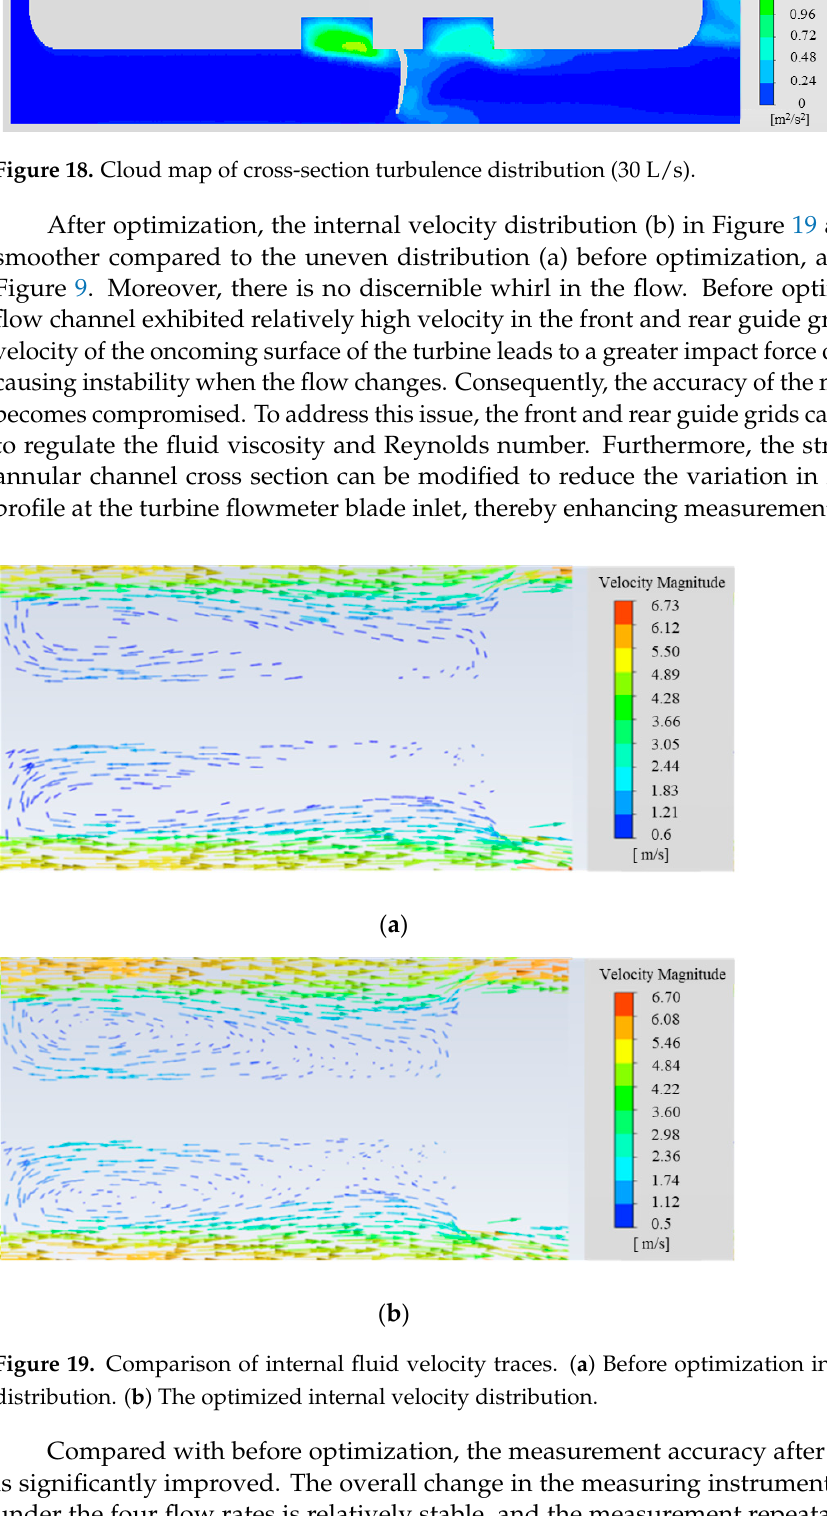
Figure 20. Change curve of instrument coefficient linearity error before and after optimization. 5. Conclusions 18